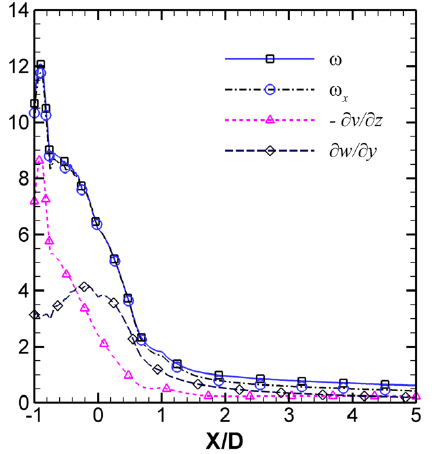
Figure 7. Vorticity at the CRVP core.